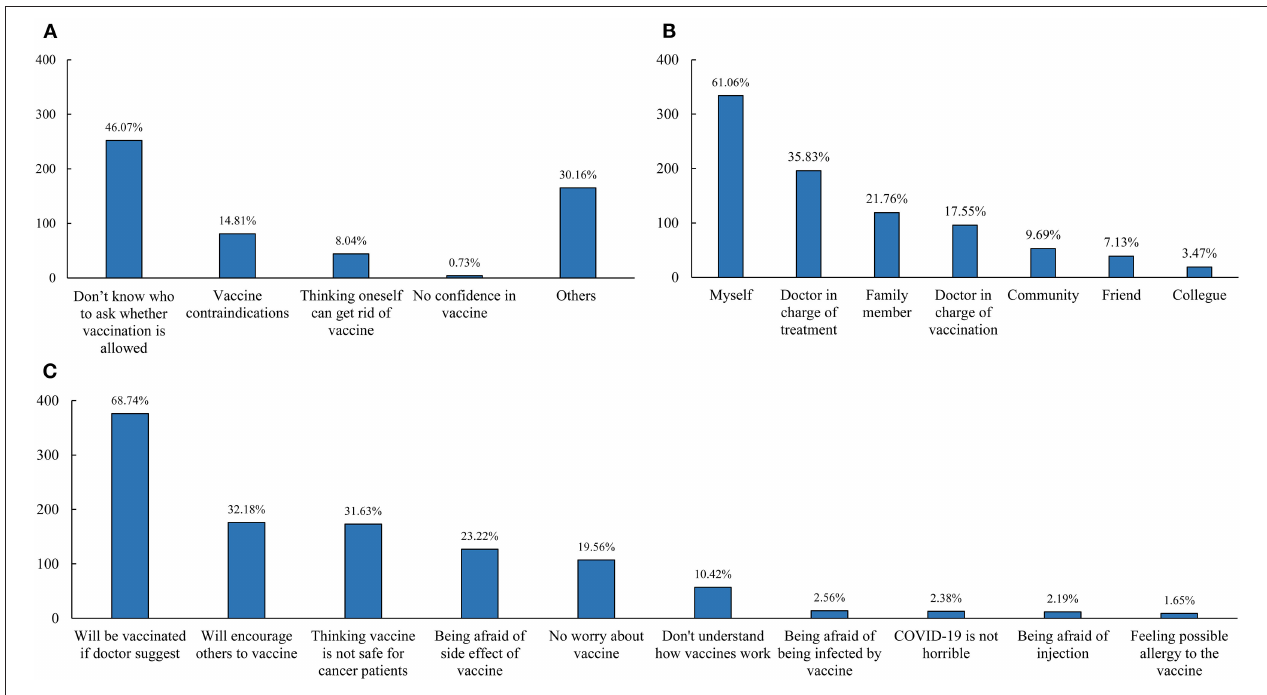
FIGURE 1 | Reasons of vaccine hesitancy/refusal among breast cancer patients (A) , the person who would influence the decision of breast cancer patients (B) , and considerations in vaccine among participants with vaccine hesitancy (C)